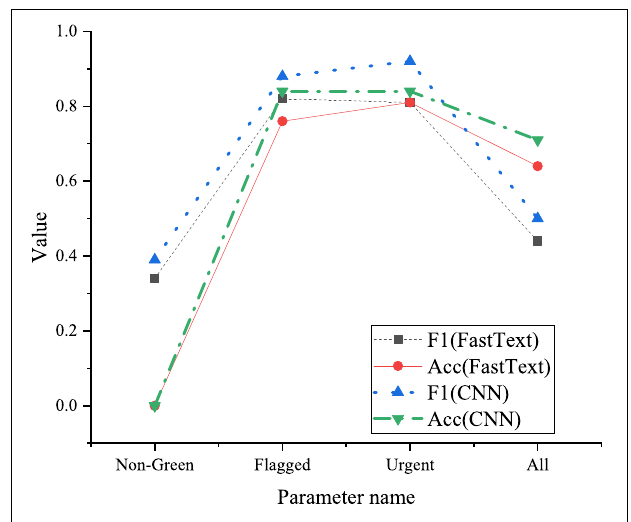
FIGURE 5 | Comparison of calculation results of different